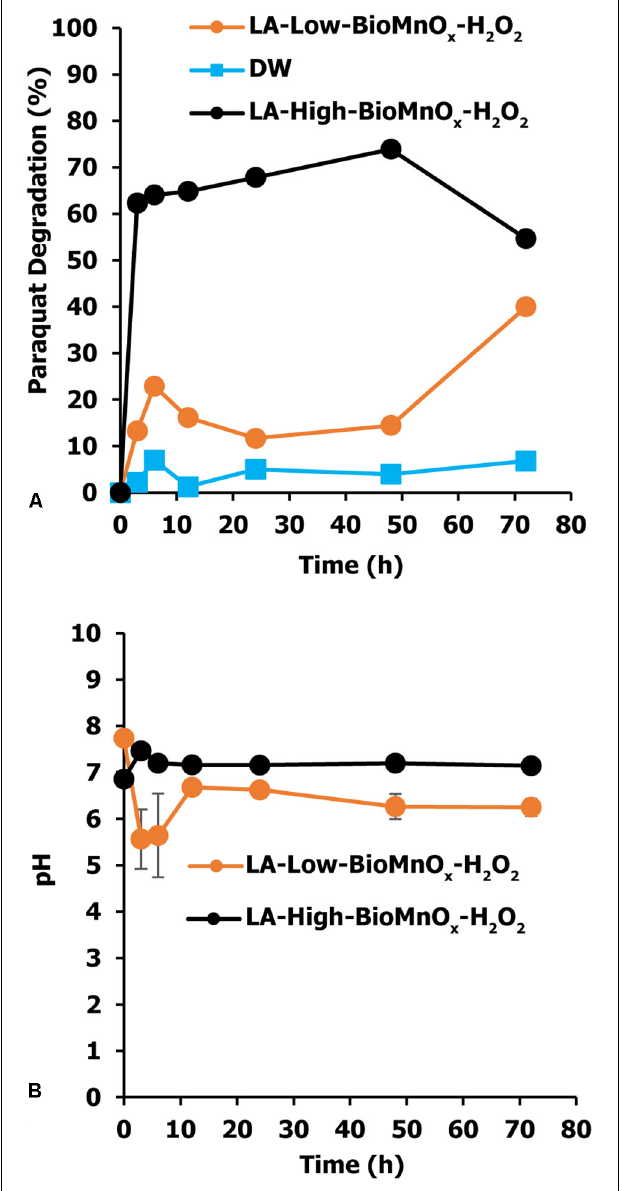
FIGURE 4 | Paraquat degradation by Fenton-like reaction using BioMnO x as catalyst. (A) Percent paraquat degradation and (B) pH level in paraquat degradation. LA-Low-BioMnO x -H 2 O 2 , living microalga with low BioMnO x plus H 2 O 2 ; DW, deionized water (control); LA, living microalga; CSMnO x -H 2 O 2 , chemical synthesis of MnOx plus H 2 O 2 ; LA-High-BioMnO x , living microalga with high BioMnO x plus H 2 O 2